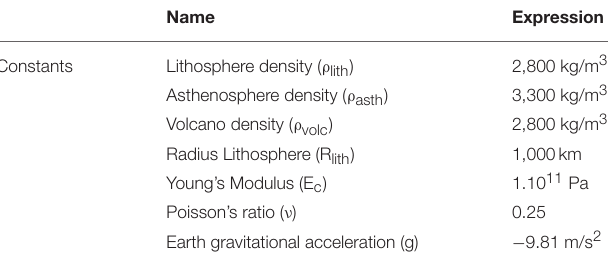
TABLE 1 | Constant physical model parameters.